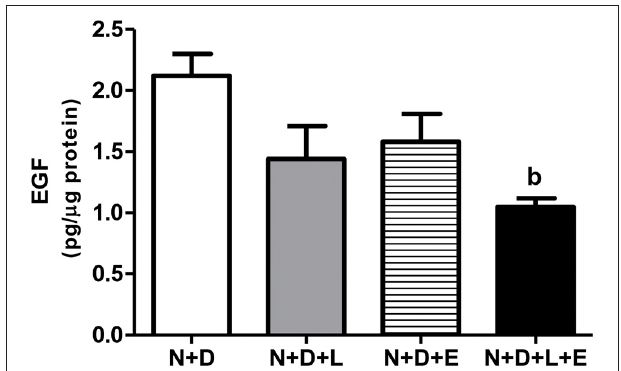
FIGURE 5 | Quantitative amount of epidermal growth factor (EGF) in the renal cortex evaluated by ELISA 60 days after 5/6 nephrectomy in vitamin D-deficient rats treated with losartan, erlotinib or losartan + erlotinib. Data are mean ± SEM. b p < 0.01 vs. N + D. N, 5/6-nephrectomized rats; D, vitamin D-deficient rats; L, losartan-treated rats; E, erlotinib-treated rats; L + E, rats concomitantly treated with losartan + erlotinib. N + D ( n = 10); N + D + L ( n =